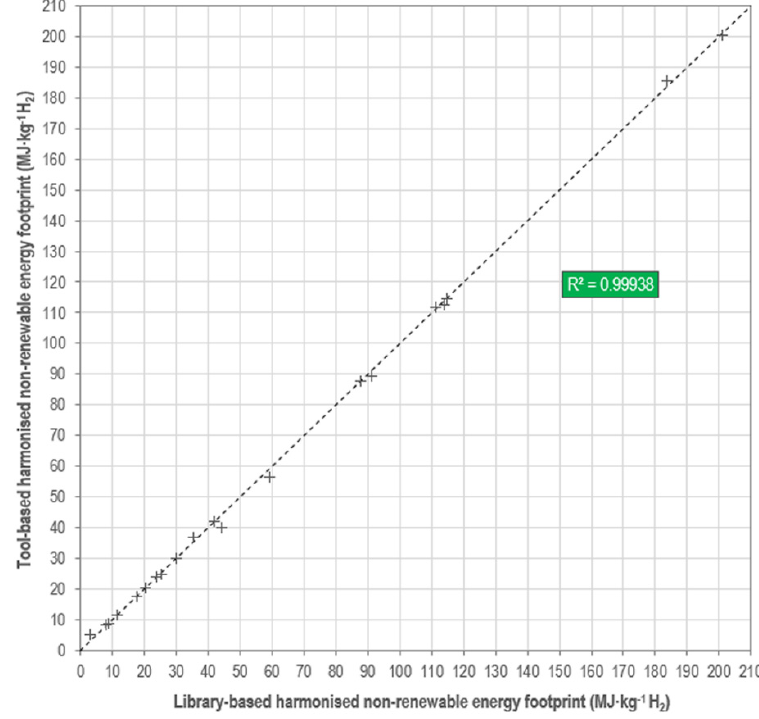
Figure 3. Linear regression between library- and tool-based harmonised energy footprints.